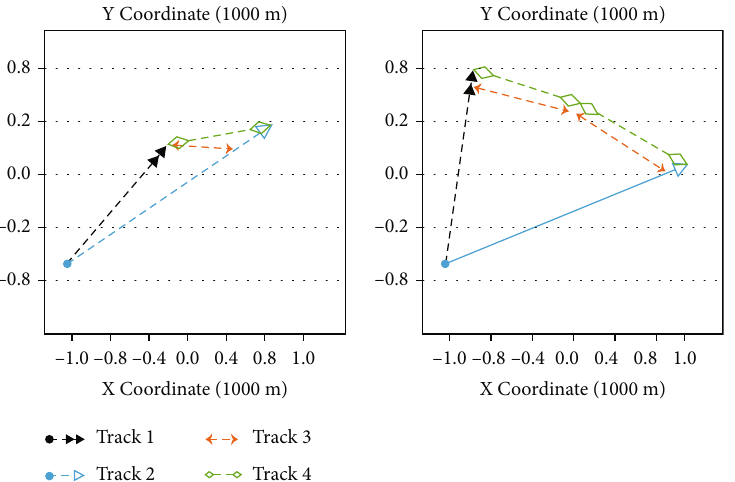
Figure 6: UAV fl ight data trajectory.